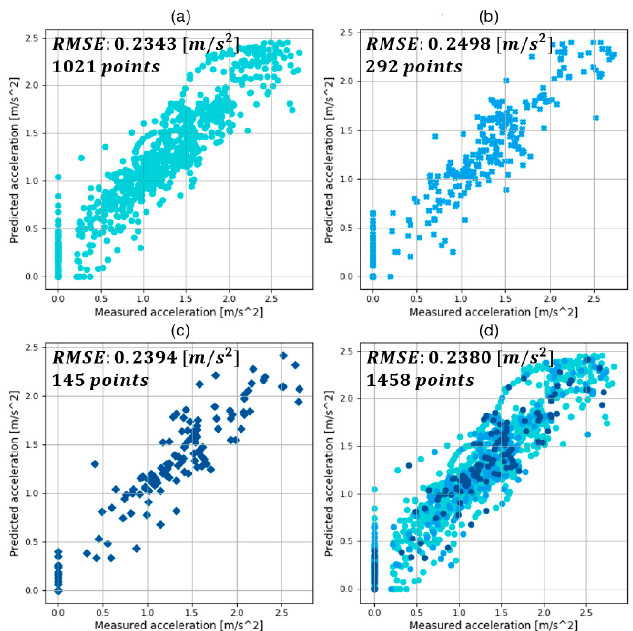
Figure 11. Results of ( a ) training; ( b ) validation; ( c ) test; ( d ) and total using the best model in speed hump conditions.